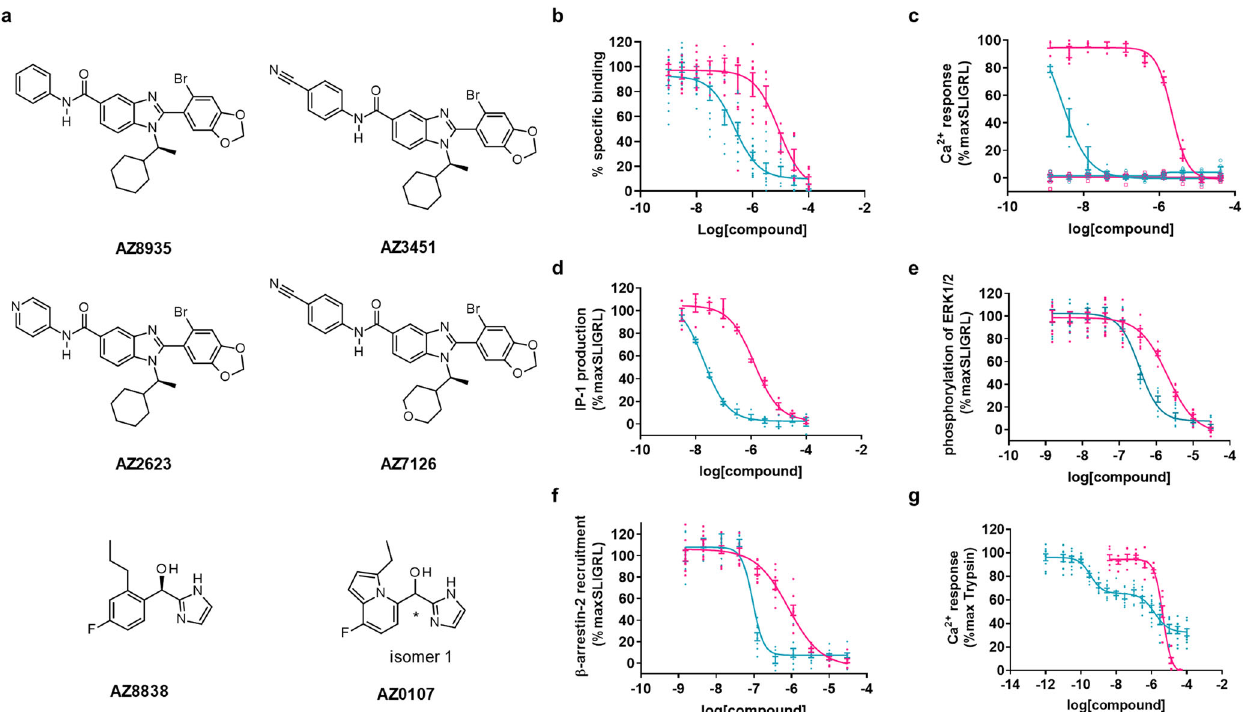
Fig. 1 Pharmacological characterisation of PAR2 antagonists. a Chemical structures of novel PAR2 antagonists. Benzimidazole antagonist (AZ8935) and optimised analogue structures (AZ3451, AZ2623 and AZ7126). Imidazole antagonist (AZ8838) and representative series analogue (AZ0107). b Binding of both series was evaluated in competition binding experiments against 2f-LIGRLO-(dtpa)Eu in CHO-hPAR2 cells. AZ8838 (magenta) and AZ3451 (cyan) had no effect when tested as agonists (open symbols) and inhibited SLIGRL-NH 2 (SLIGRL) activation (closed symbols) of c Ca 2 + mobilisation, d IP1 formation, both in 1321N1-hPAR2 cells and e phosphorylation of ERK1/2 and f β -arrestin-2 recruitment, both in U2OS-hPAR2 cells. g Both series also inhibited trypsin activation of PAR2 in Ca 2 + mobilisation in 1321N1-hPAR2 cells but interestingly AZ3451 gave a biphasic response whereas AZ8838 was monophasic. Inhibition of trypsin was evaluated in the presence of 1 µ M Vorapaxar to suppress any contributions by PAR1 endogenously present in 1321N1 cells. Antagonist responses were calculated as % inhibition of agonist response in the absence of the antagonist. Graphs show representative data of 2 or more experiments, presented as individual data points with error bars denoting s.e.m. The comprehensive pharmacological data are stated